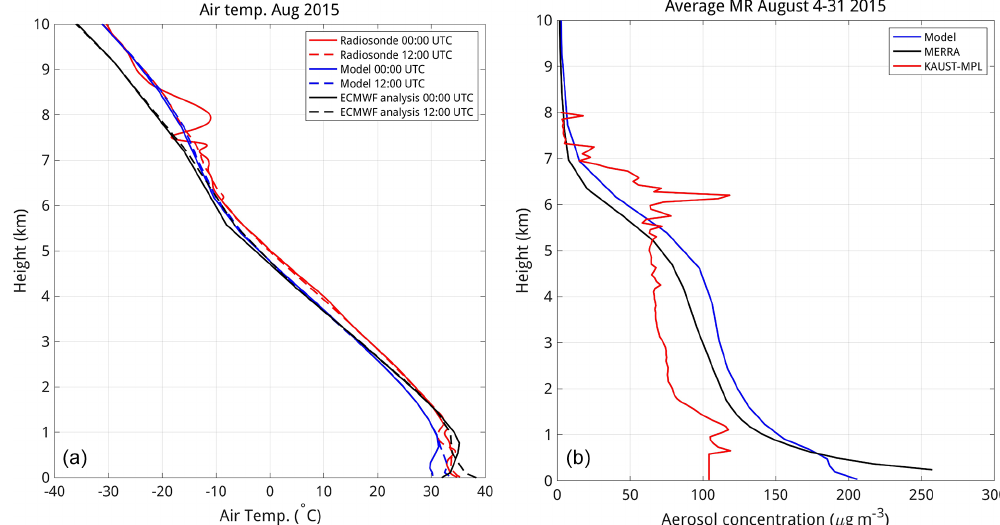
Figure 3. Average vertical profiles of air temperature (a) and aerosol concentrations (b) compared to reference observations. The air tem- perature profile was compared against ECMWF operational analysis and radiosonde station data at King Abdul Aziz International Airport, Jeddah (21.7 ◦ N, 39.18 ◦ E) during the daytime (12:00UTC) and nighttime (00:00UTC) by averaging during the study period (4–31 Au- gust 2015). Simulated aerosol mixing ratios were compared against MERRA-2 reanalysis and MPL lidar station data at KAUST (22.30 ◦ N, 39.10 ◦ E) for 4–31 August 2015.